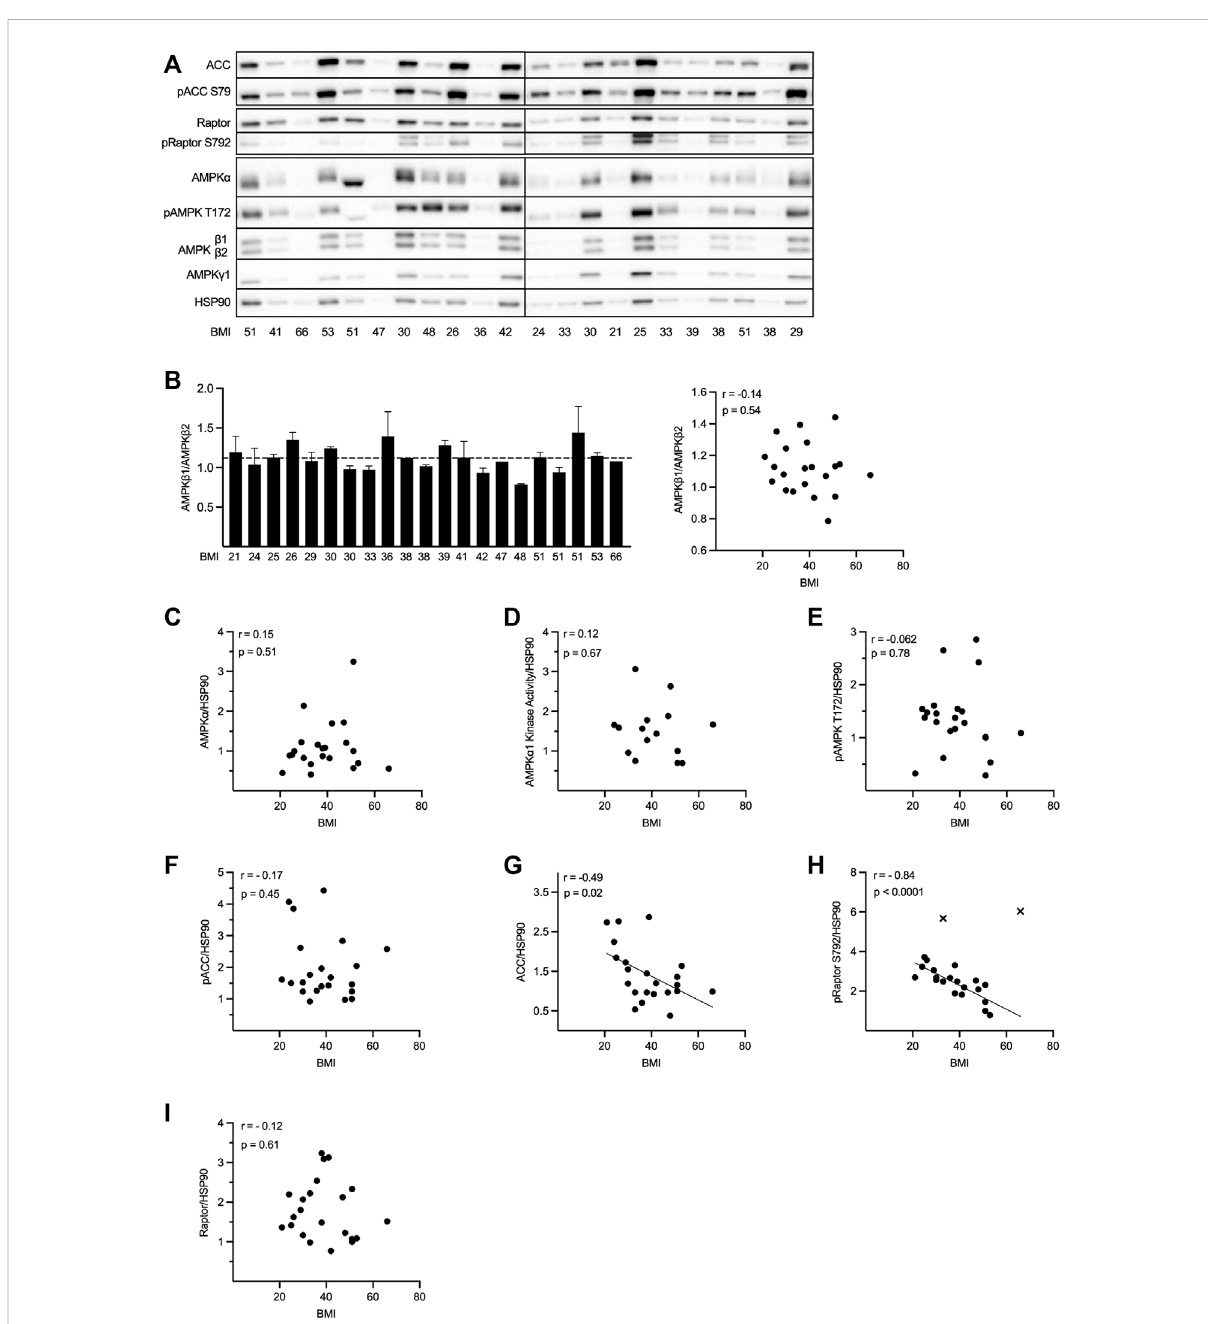
The expression and activity of AMPK is unchanged whereas Raptor S792 phosphorylation and expression of ACC are decreased in adipocytes from obese individuals. Primary adipocytes were isolated from human subcutaneous adipose tissue from 22 individuals (BMI 38.7 ± 11.5 kg/m 2 [mean ± SD]; seven male, 15 female) and lysed immediately after isolation. AMPK α 1 in vitro kinase activity measurements [for 15 (BMI 41.7 ± 11.5 kg/ m 2 ) out of the total 22 lysates] as well as Western blot analysis of AMPK subunit ( α 1, β 1, β 2, and γ 1) expression and phosphorylation of AMPK T172 and AMPK downstream targets ACC at S79 and Raptor at S792 were performed. (A) Representative blots from two independent gel runs are shown. (B) AMPK β 1/ β 2ratio for 21out of22 individuals (for oneindividual β 1/ β 2was undetectable intheWB; leftpanel) and plotted against BMI(right panel).Bargraphshowsmean+SDoftwoindividualgelruns. (C – I) AMPK α (C) ,AMPK α 1 invitro kinaseactivity (D) ,pAMPKT172 (E) ,pACCS79 (F) ,ACC (G) , pRaptor S792 (H) ; excluded outliers are indicated as cross] and Raptor (I) levels normalized to HSP90 and plotted against BMI. Western blot signals normalized to HSP90, as well as kinase activity (1 corresponds to an activity of 44.5 mU/mg) were expressed as fold changes relative to one individual. Correlation analyses were performed using Pearson correlation